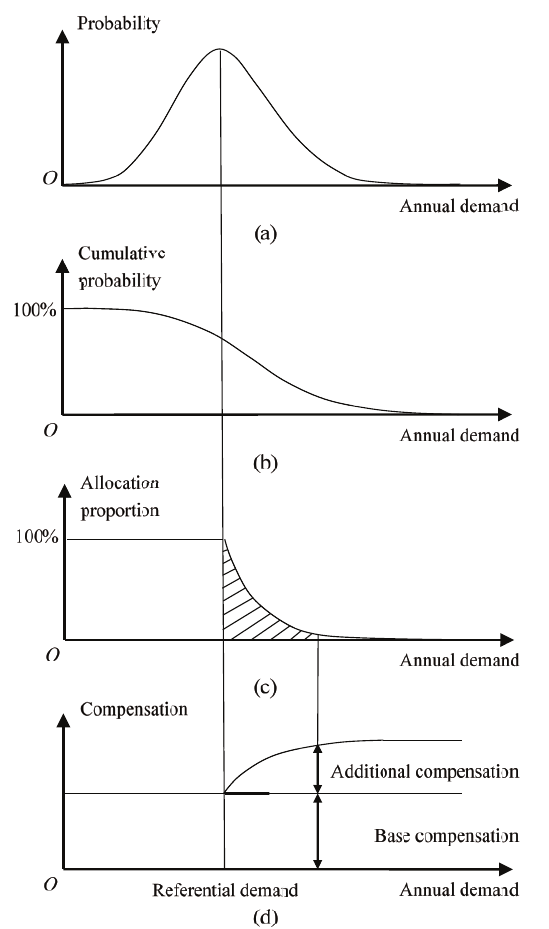
Figure 1. Compensation analysis under different